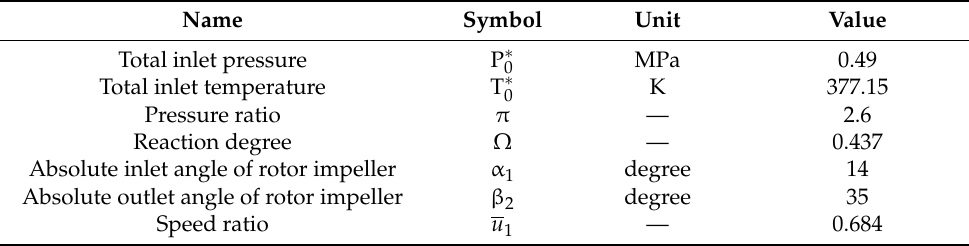
Table 3. Table of design parameters for